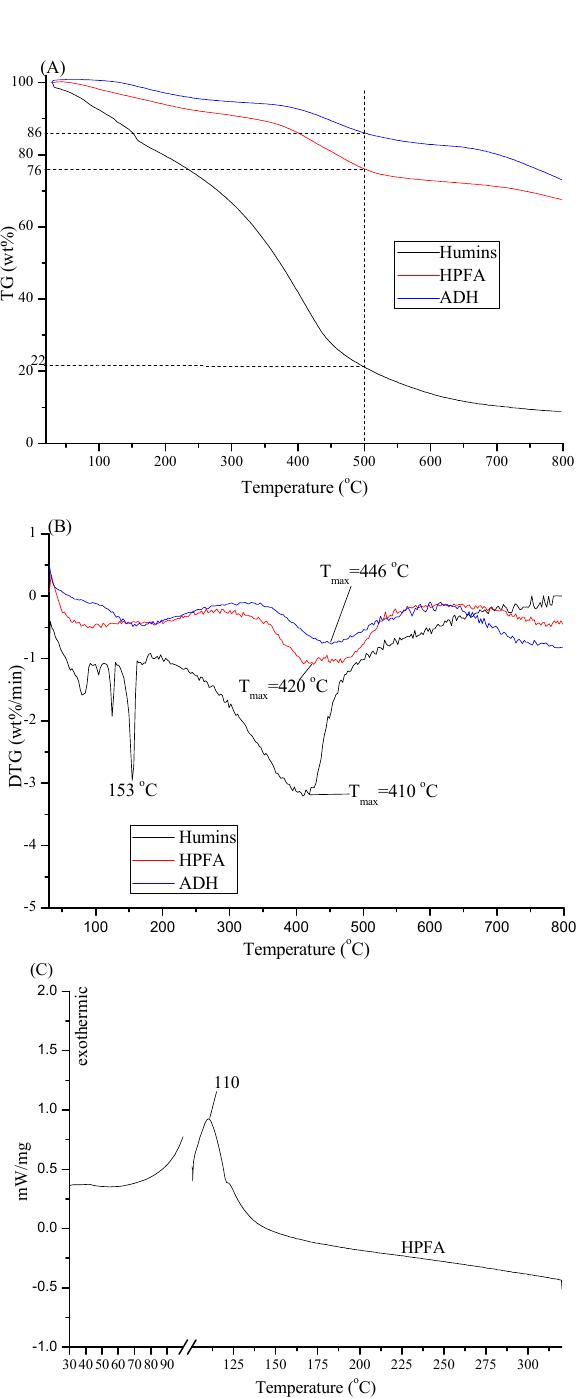
Figure 2. Thermal analysis spectra. ( A ) TG of humins, cured ADH and HPFA; ( B ) DTG of humins, cured ADH and HPFA; ( C ) DSC of HPFA.